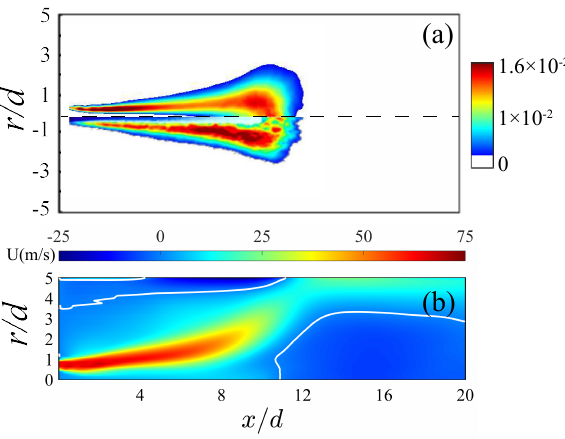
Figure 5. Flame and flow structures for Case 1. ( a ) Upper panel: mean distribution of the OH mass fraction for Case 1; lower panel: Abel transform of OH ∗ emissions from the experiments [13]. ( b ) Mean distribution of the axial velocity. The white line shows the iso-line of zero axial